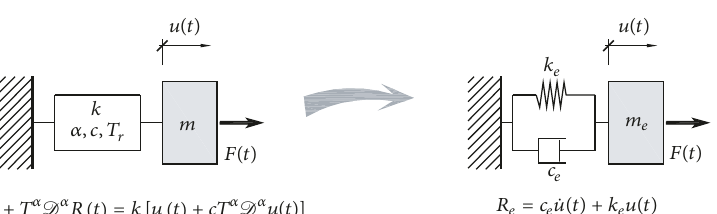
Figure 1: The original single-degree-of-freedom model with viscoelastic behavior based on the fractional derivatives and its equivalent linear viscous model. D 𝛼 (∙) denotes the 𝛼 -order fractional